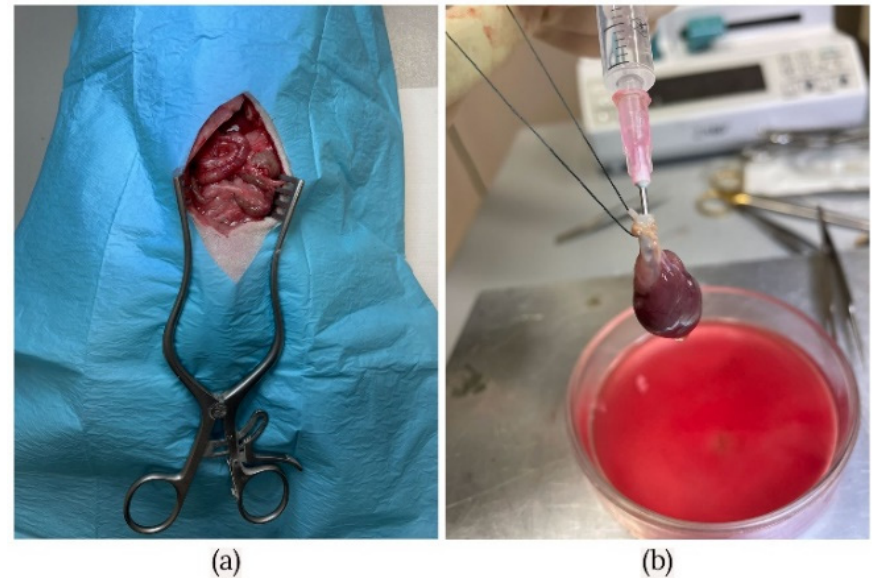
Figure 1. ( a ) Heart explantation—preparing the access to the retroperitoneum. ( b ) Representative image of rat heart before the decellularization process.